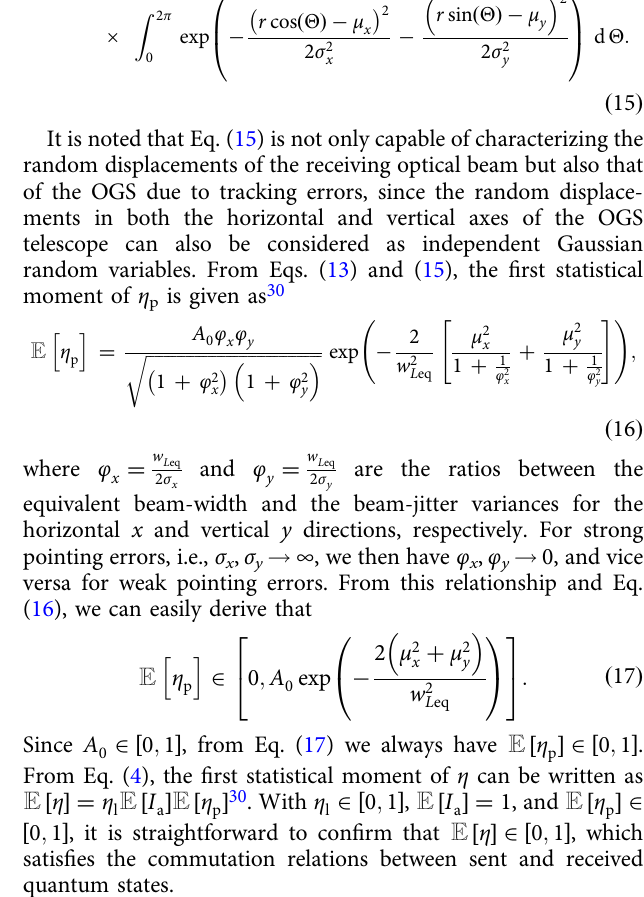
satis fi es the commutation relations between sent and received quantum